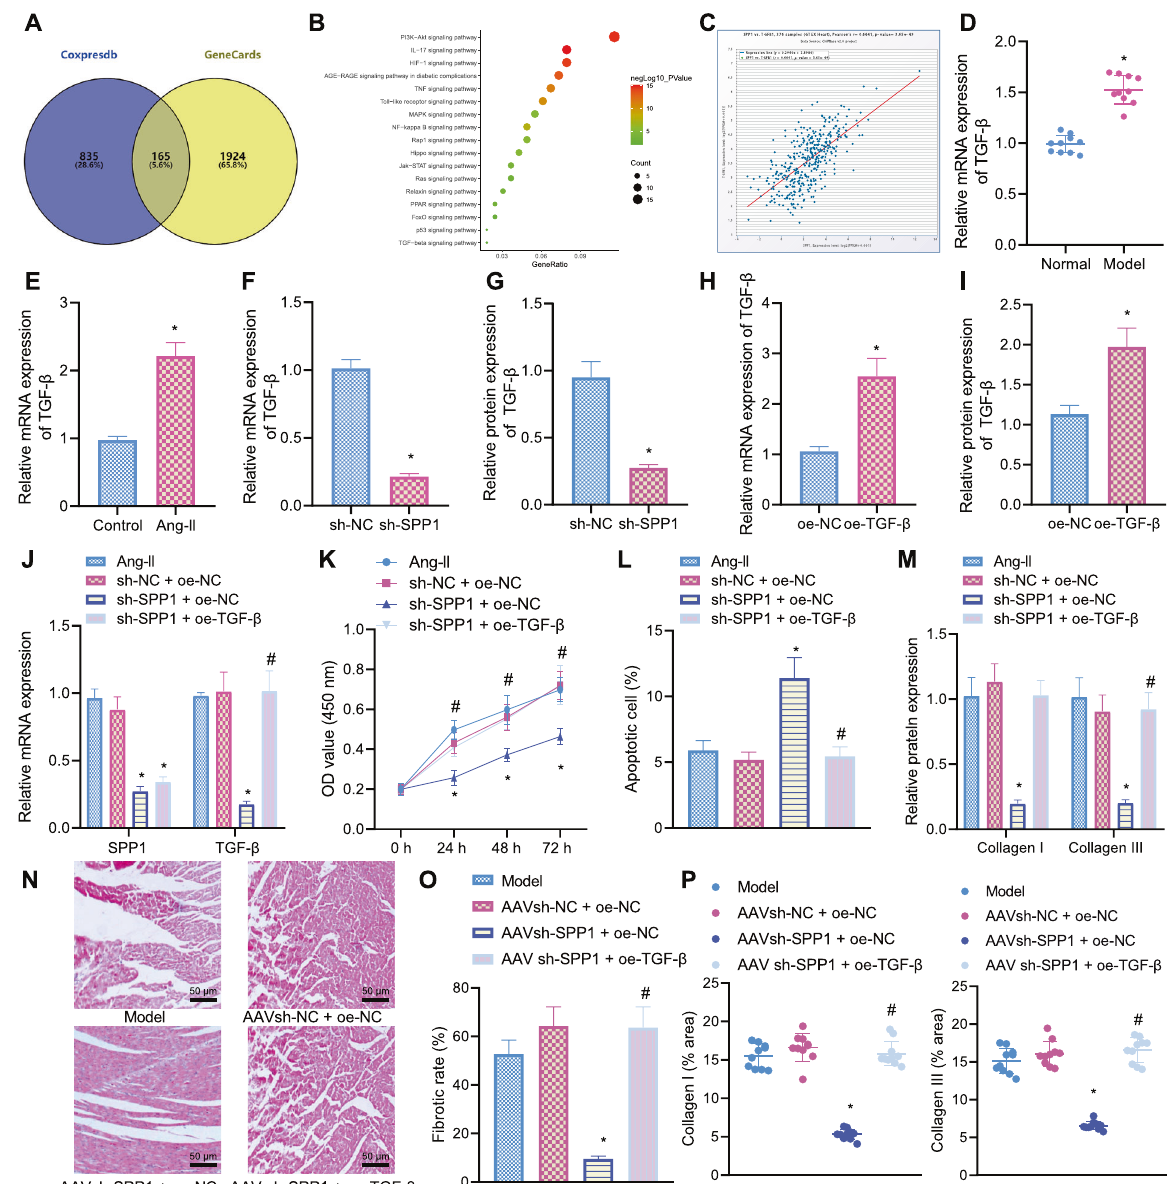
Fig. 3 SPP1 enhances atrial fi brosis by increasing the expression of TGF- β . A Venn diagram of co-expressed genes of SPP1 in the Coxpresdb database and atrial fi brosis-related genes. B KEGG enrichment analysis on candidate genes. The abscissa represents GeneRatio. C Correlation between SPP1 and TGF- β in heart tissues analyzed by the Chipbase v2.0 database ( r = 0.6641, p-value = 3.65e − 49). D RT-qPCR detection of TGF- β expression in atrial tissues of normal and Ang II-treated mice. E RT-qPCR detection of TGF- β expression in control and Ang II-induced HL-1 cells. F RT-qPCR detection of TGF- β expression in HL-1 cells treated with sh-SPP1. G Western blot analysis of TGF- β protein in HL-1 cells treated with sh-SPP1. H RT-qPCR detection of TGF- β expression in HL-1 cells treated with oe-TGF- β . I Western blot analysis of TGF- β protein in HL-1 cells treated with oe-TGF- β . J RT-qPCR detection of SPP1 and TGF- β expression in HL-1 cells treated with sh-SPP1 or combined with oe- TGF- β . K CCK-8 detection of cell viability in HL-1 cells treated with sh-SPP1 or combined with oe-TGF- β . L TUNEL detection of apoptosis of HL-1 cells treated with sh-SPP1 or combined with oe-TGF- β . M Western blot analysis of collagen I and collagen III proteins in HL-1 cells treated with sh-SPP1 alone or in combination with oe-TGF- β . N HE staining of pathological changes of atrial tissues of Ang II-induced mice treated with sh- SPP1 or combined with oe-TGF- β . O Masson ’ s trichrome staining of atrial fi brosis degree in Ang II-induced mice treated with sh-SPP1 or combined with oe-TGF- β . P IHC analysis of collagen I and collagen III proteins in atrial tissues of Ang II-induced mice treated with sh-SPP1 or combined with oe-TGF- β . * p < 0.05, compared with the normal mice, control HL-1 cells, Ang II-induced HL-1 cells treated with sh-NC, oe-NC or sh-NC + oe-NC or Ang II-induced mice treated with sh-NC + oe-NC. # p < 0.05, compared with the Ang II-induced HL-1 cells or mice treated with sh-SPP1 + oe-NC. All experiments were repeated three times independently. n = 10 for mice in each fi brosis (Fig. 5C, D). The expression of PCSK9 was enhanced SREBP2 triggers mtDNA damage by upregulating PCSK9 following SREBP2 overexpression (Fig. 5E). As illustrated in Fig. 5F, t expression in vitro the expression of SREBP2 was reduced in the presence of sh- The detection results of mtDNA damage and mtROS showed an increase in Ang II-induced HL-1 cells (Fig. 5A, B). PCSK9 over- expression occurred in both mouse and cell models of atrial